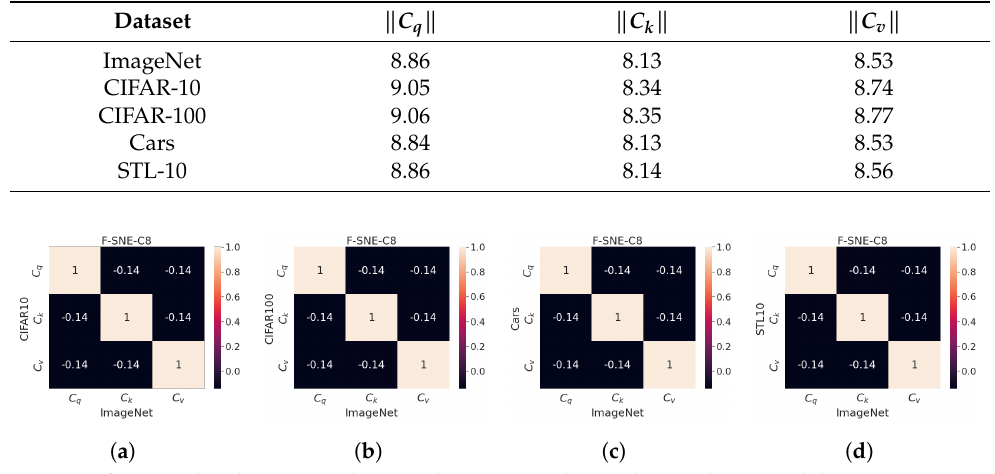
Figure 4. l 2-normalized C q , C k , and C v are dot-producted according to the trained datasets. “IMNet”, “C10”, “C100”, and “S10” denote ImageNet, CIFAR-10, CIFAR-100, and STL-10, respectively. C q , C k , and C v are extracted from the F-SNE-C8-S model. ( a ) IMNet-C10. ( b ) IMNet-C100. ( c ) IMNet-Cars. ( d )